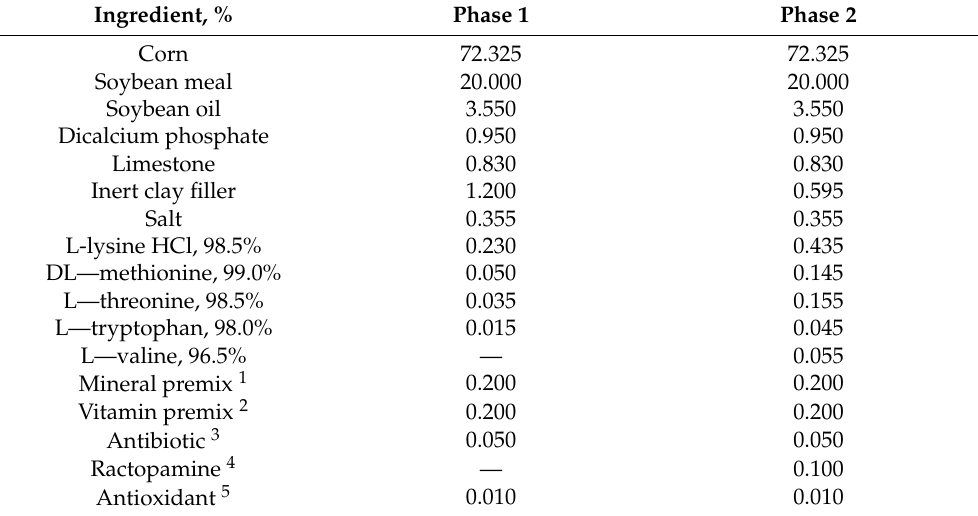
Table 1. Diets composition.